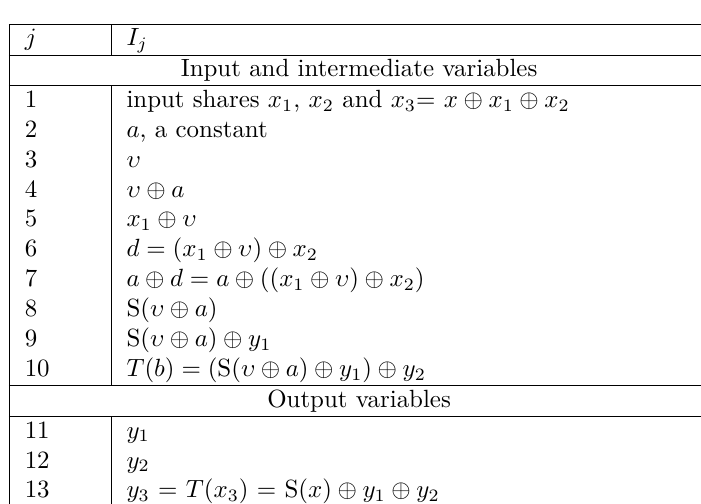
Table 1: List of variables of Algorithm 1.